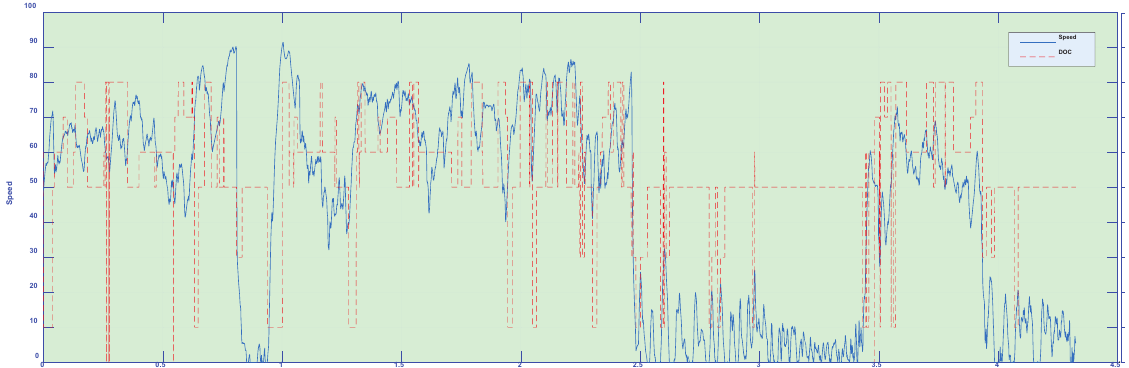
Figure 9 The label result of longitudinal